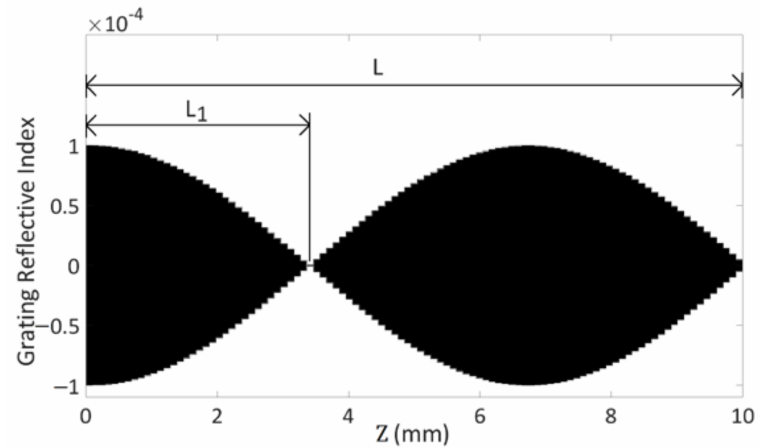
Figure 4. Refractive index modulation of AMFG for 0.51th-order